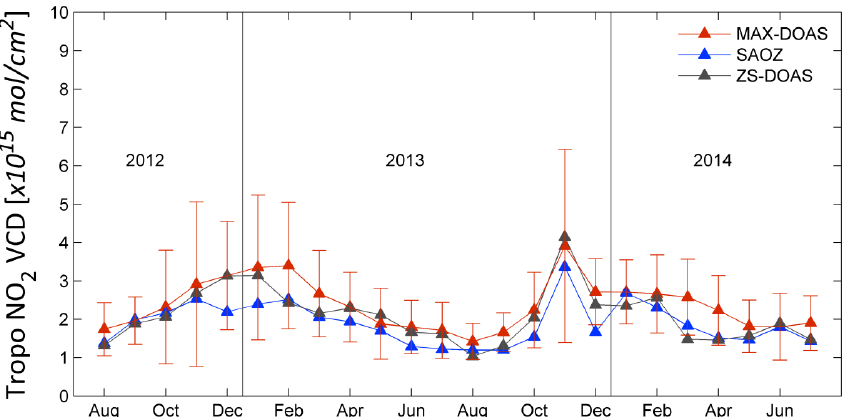
Figure 10. TVCD monthly mean time series at the OHP station for ZS-DOAS, SAOZ and MAX-DOAS for the period August 2012–July 2014. The error bars on the MAX-DOAS data points correspond to the 1-sigma standard